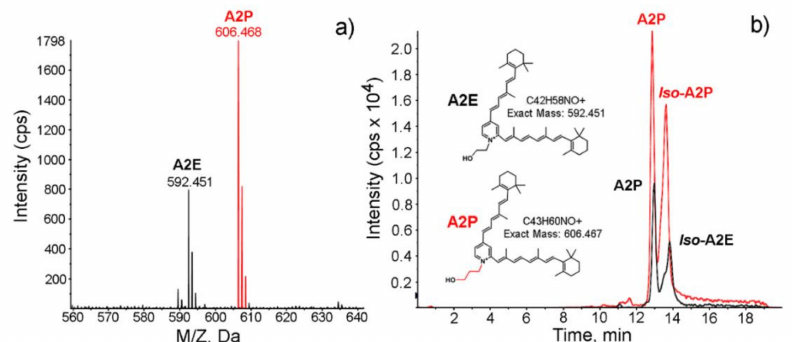
Figure 4. Quantification of A2E ( N- retinylidene- N- retinylethanolamine) in lipofuscin granules by LC / MS. Panel ( a ) shows the positive ion ESI (electrospray ionization) mass spectrum of the M + ions of A2E (in F1 granules, black peaks) and internal standard A2P (red peaks). Extracted ion chromatograms (EICs) of m / z 592.4 for A2E (black) and m / z 606.4 for A2P (red) are displayed in panel ( b ), along with the structures of A2E, A2P, and their exact masses.